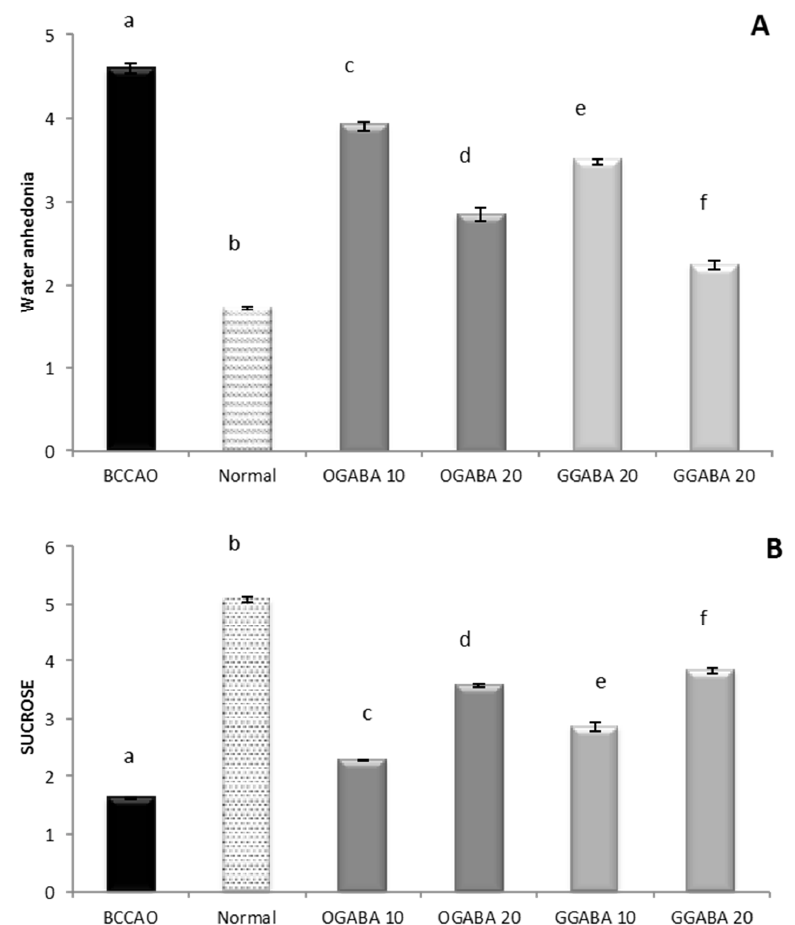
Figure 3. Volume of water ( A ) and sucrose solution ( B ) consumption in stroke-induced anhedonia model. Data are shown as a mean (mL) ± SD ( n = 3); different letters indicate statistically significant differences ( p < 0.05) between the two groups.